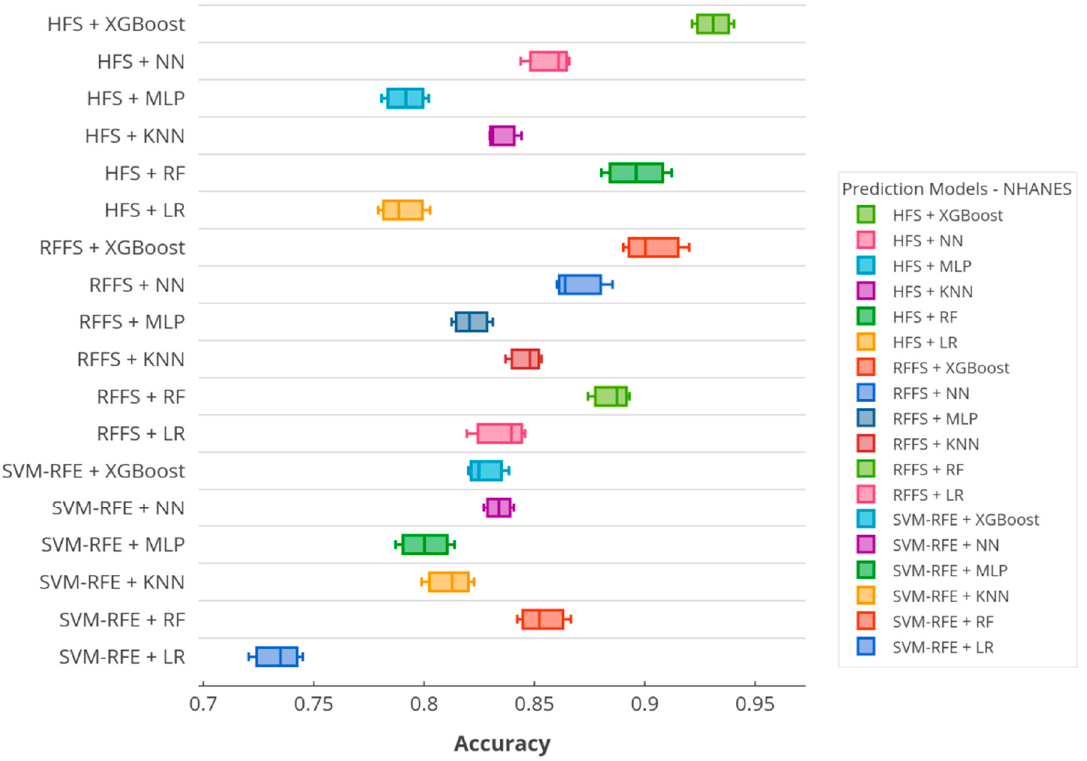
Figure 6. Boxplot of the accuracy over prediction models in the NHANES dataset.